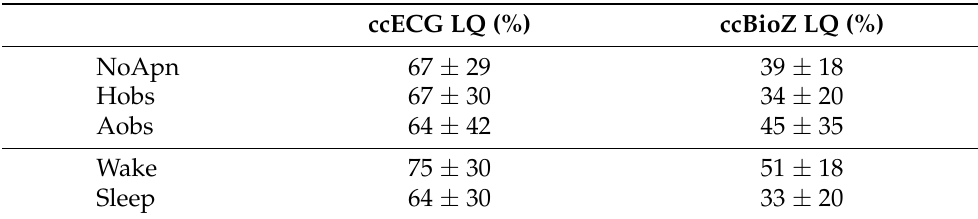
Figure 5. Results of ccBioZ evaluation when applying SQIs (high-quality data, HQ) and comparing against gold standard PSG RIP. The increase in ( A ) percentage of ccBioZ classified as HQ in the current study is clear, when comparing to ( B ) the HQ ccBioZ data from a previous data collection [10]. ( C , D ) show the respiration rate error with and without SQI processing. ( E ) shows the average correlation between ccBioZ and gold standard RIP with and without SQI processing. Table 2. Overview of low-quality (LQ) labeled segments for ccECG and ccBioZ with respect to occurrence of apneas and sleep